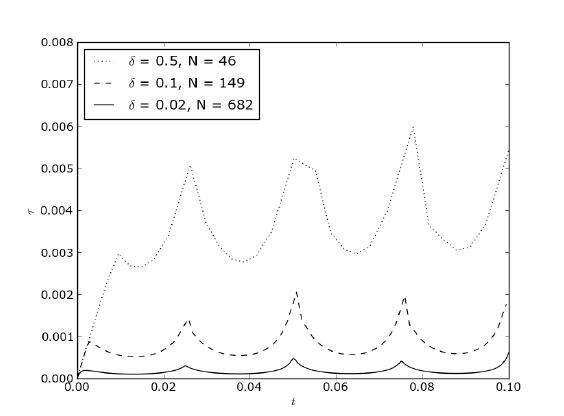
Figure 8. The time-history of the time step for the periodic right-hand side. Accounting features of the problem rerults in the choice of a smaller step in the high-gradient region of the right-hand side and a fairly rapid transition to a nearly periodic set of time